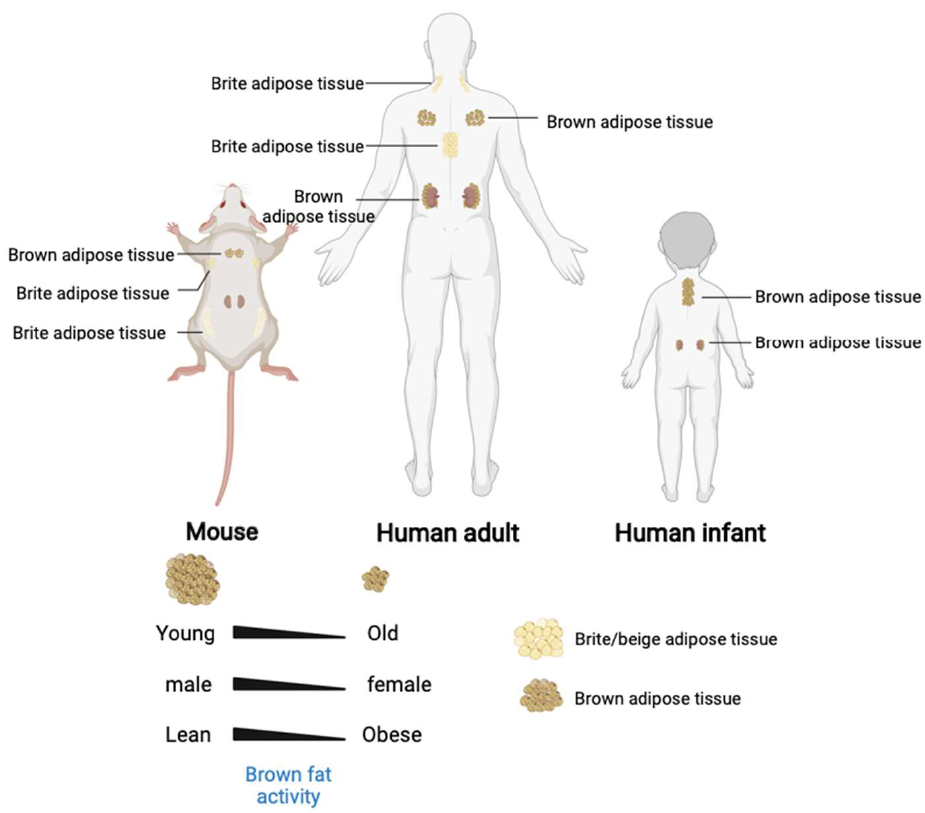
Figure 2. The brown and beige adipose tissue distribution in human and mouse. In addition, the brown adipose tissue activity and quantity decreased with age and associated with gender and stat-